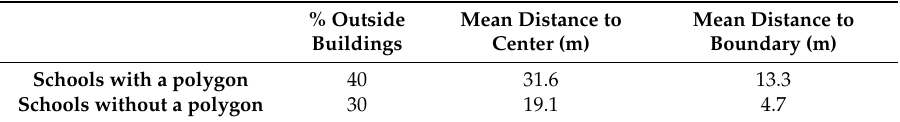
Table 6. Summary of the school locations in relation to building/extent center and boundary.